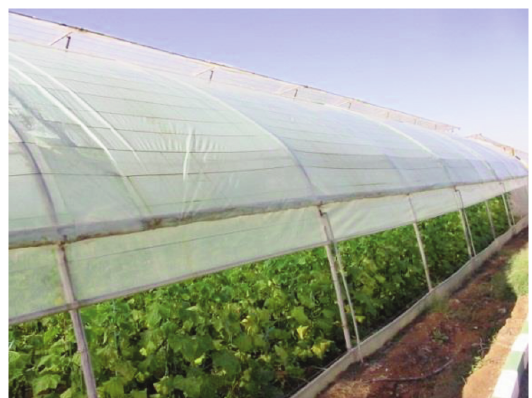
Fig. 4 ­ Aeration valves are usually not covered with netting by greenhouse owners and this allows the entry of insect